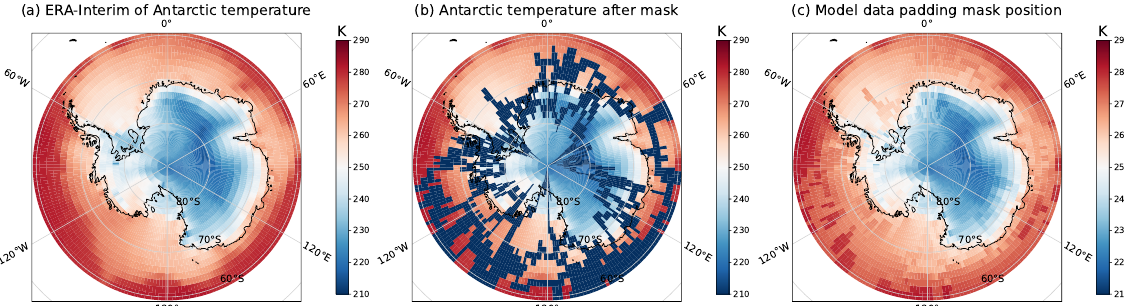
Figure 2. ERA-interim of Antarctic temperature as ground truth ( a ), ERA-interim of Antarctic temperature with artificial random 30% mask rate ( b ) and E3SM model temperature data as initial value of the mask area ( c